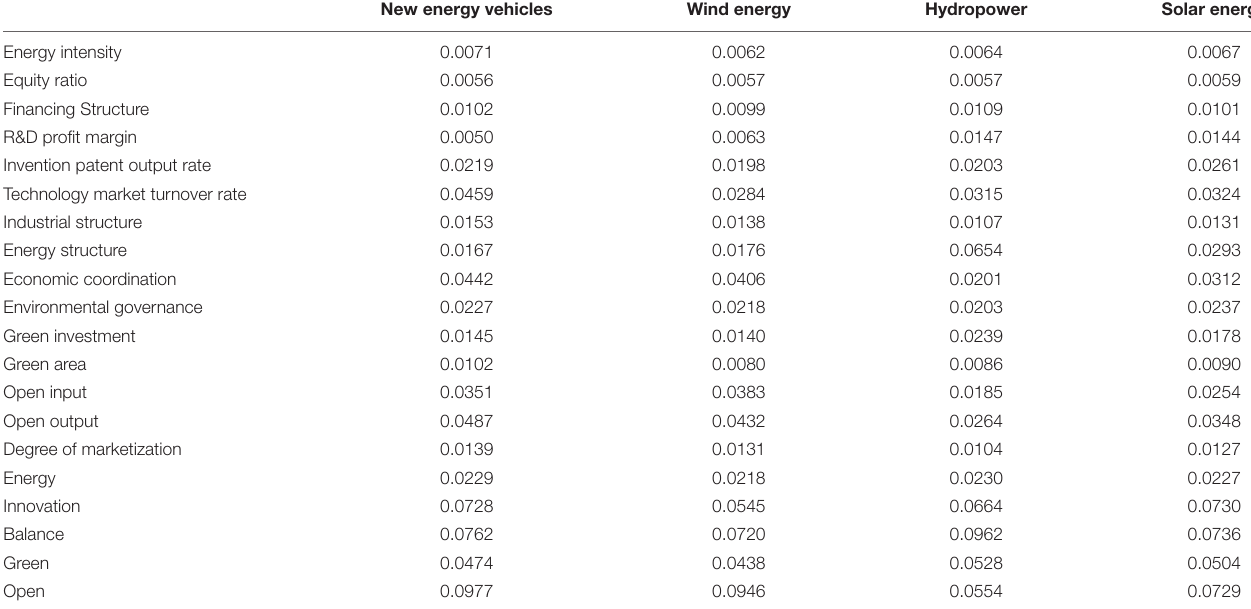
TABLE 3 | Comprehensive index obtained by entropy method.